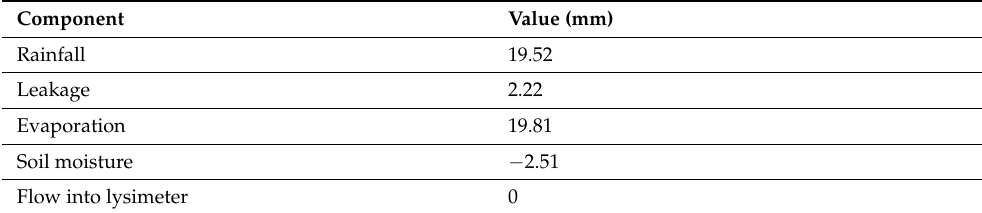
Table 2. Monthly water balance for November 2018.